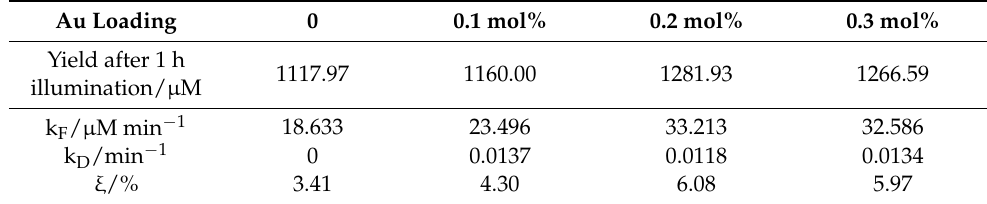
Table 3. Summary of k F , k D and ξ of different Au/ZnO during H 2 O 2